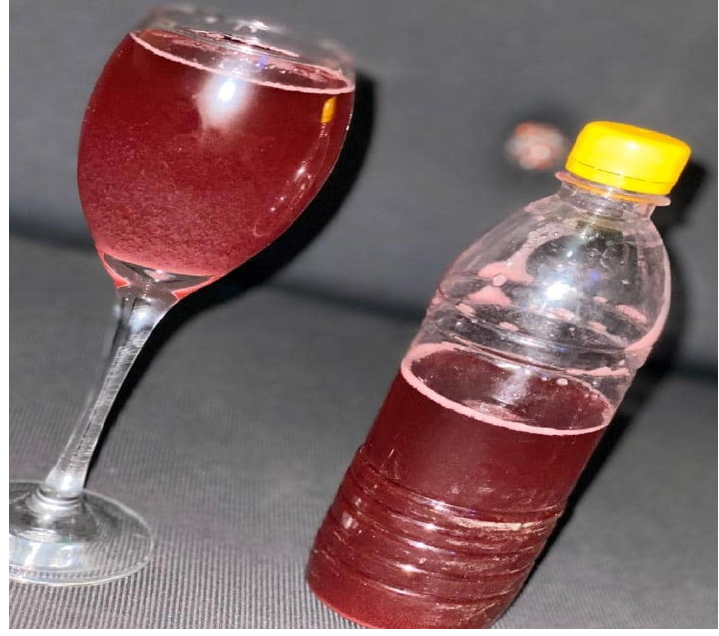
Figure 2. Locally produced sobolobo.